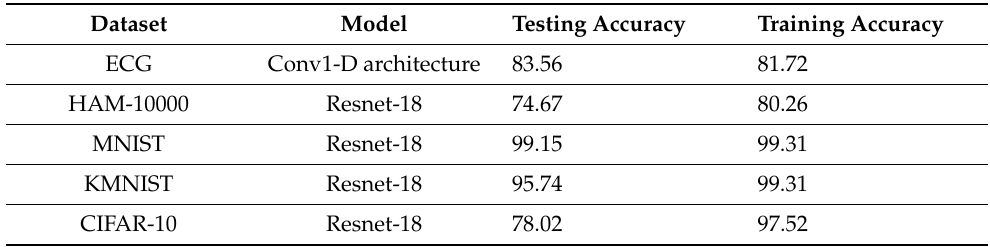
Table 4. Training and testing accuracy for centralized